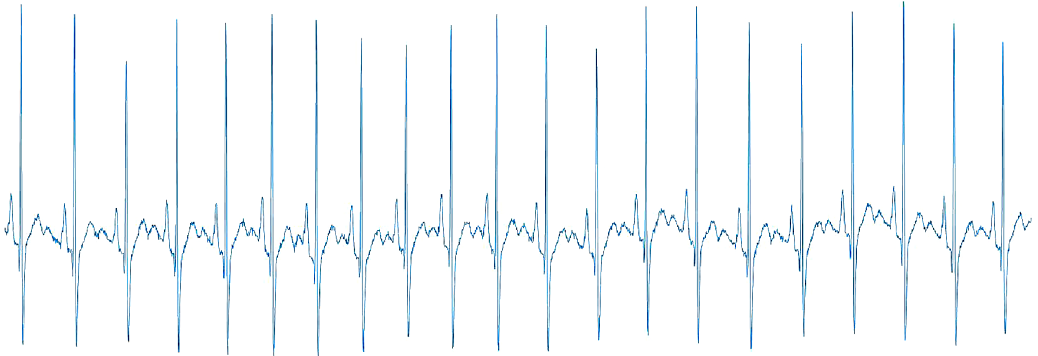
Figure 4. The 2-D ECG converted from 1-D